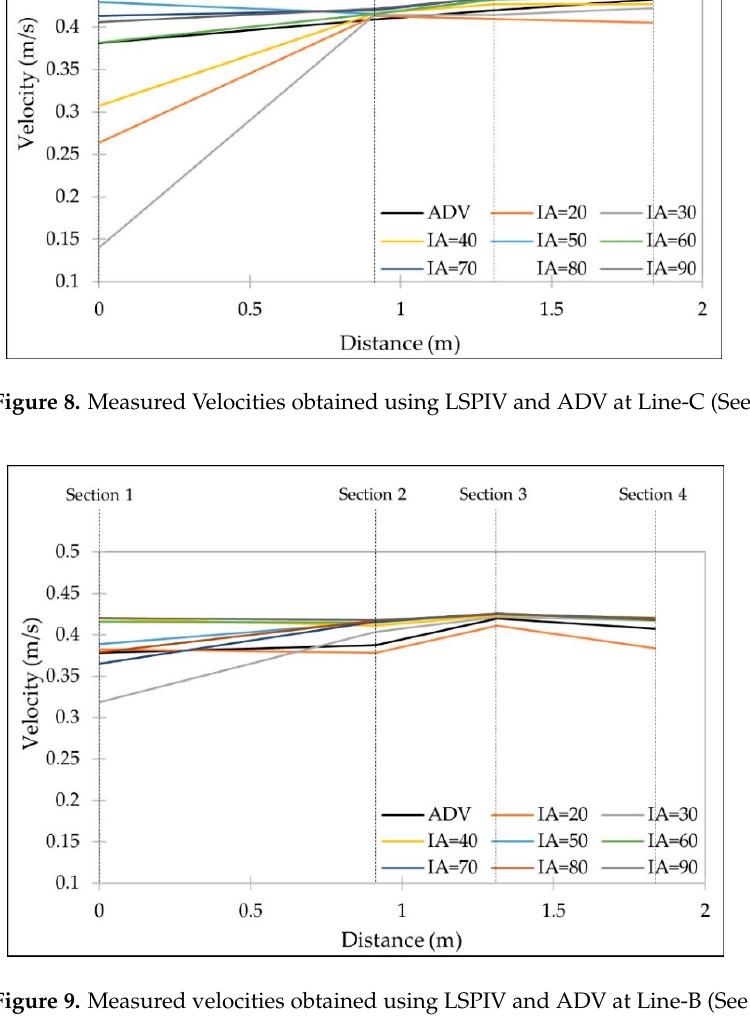
Figure 9. Measured velocities obtained using LSPIV and ADV at Line-B (See Figure 5).